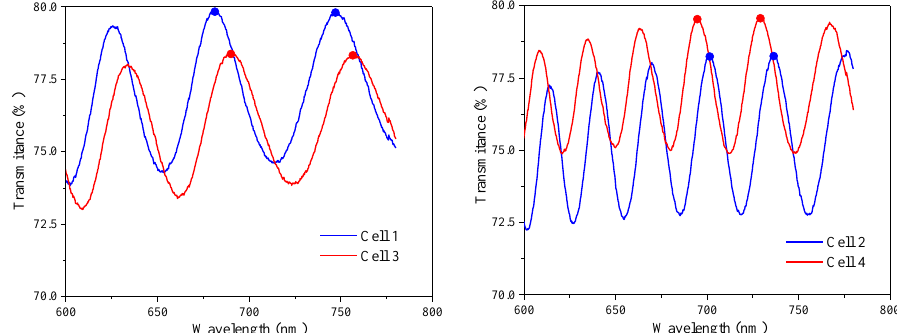
Figure 10. Wavelength-transmittance (λ -T) curves of four types of LC cells.